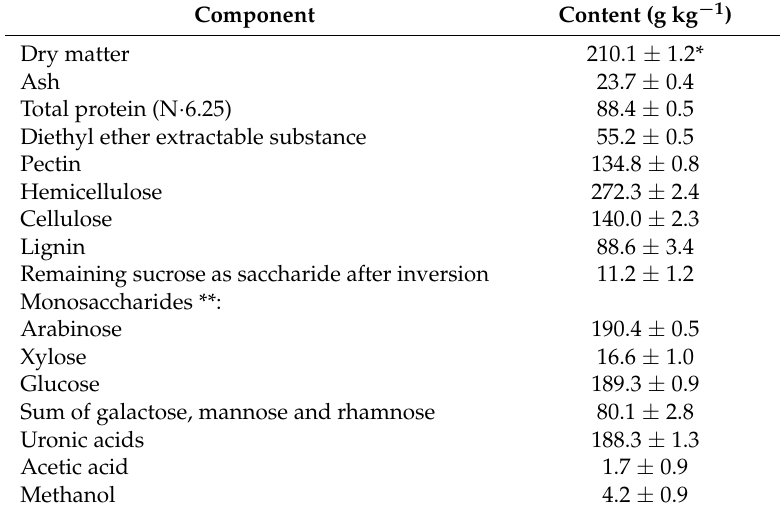
Table 1. Chemical composition of sugar beet pulp